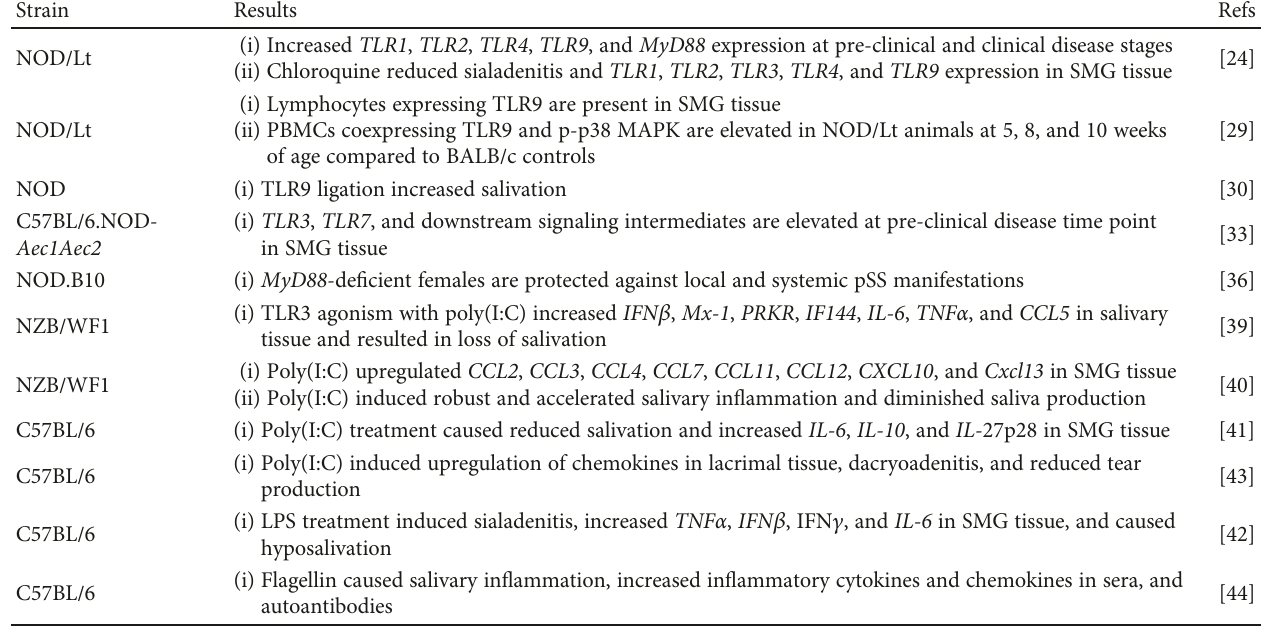
Table 1: Evidence for TLR activation in murine studies of